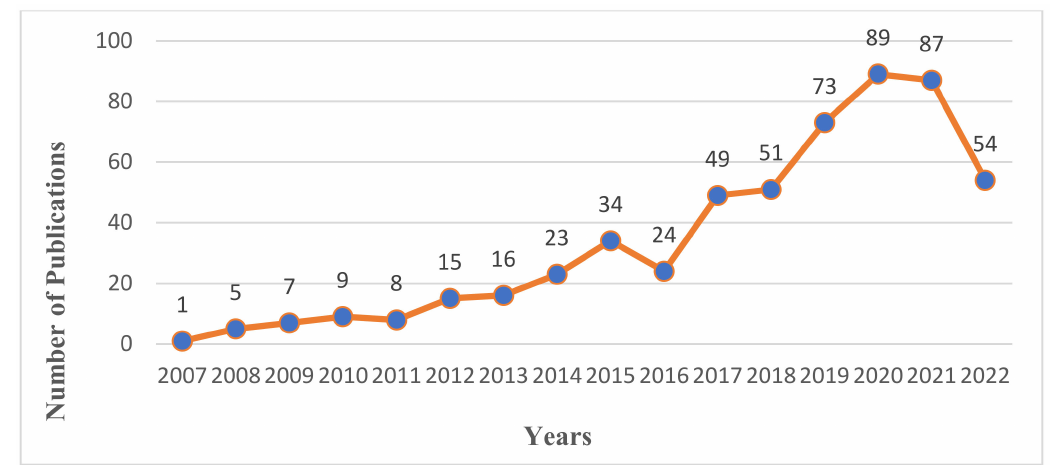
Figure 2. The number of ICH publications in foreign journals from 2007 to